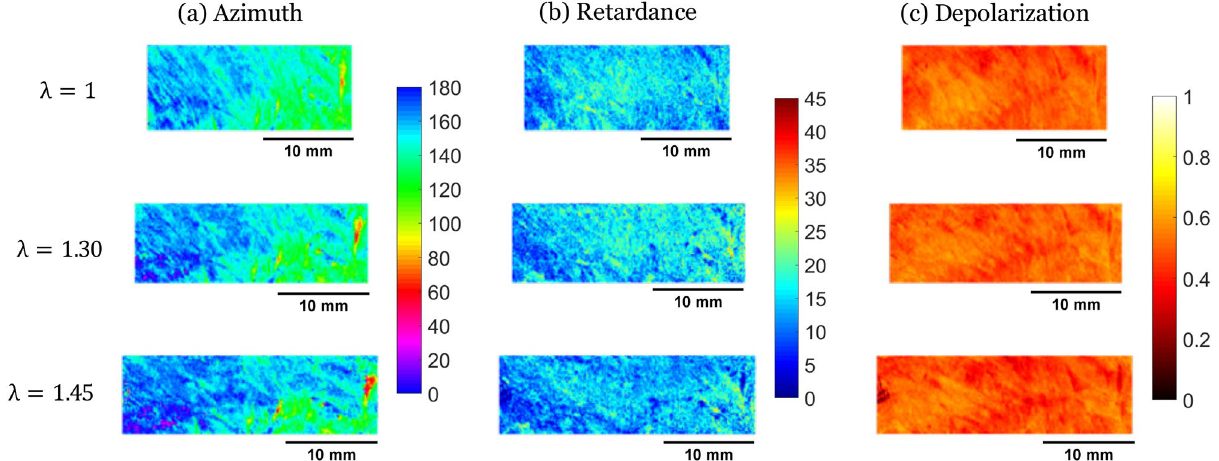
Figure 4. Maps of the Mueller polarimetry parameters [( a ) Azimuth α (in ◦ ), ( b ) retardance R (in ◦ ), ( c ) depolarization (cid:31) ] measured on sample 1 at different imposed stretches ( (cid:31) = 1, (cid:31) = 1.30, (cid:31) = 1.45 ).